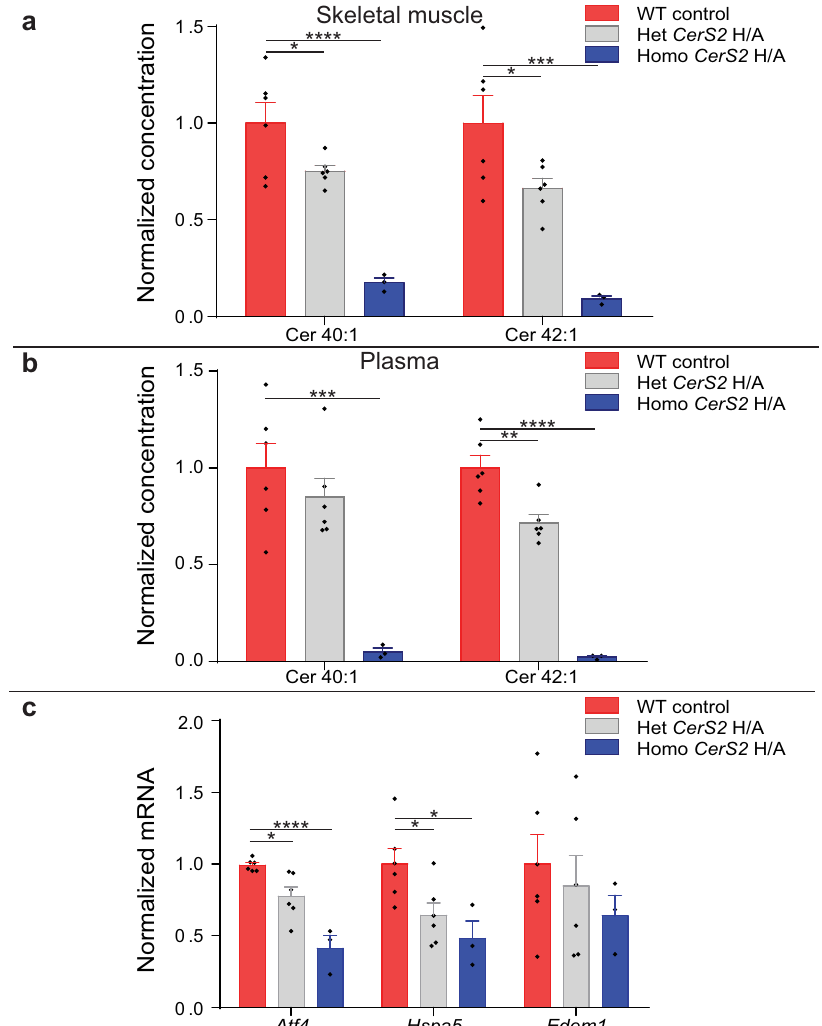
Fig. 6 Transgenic CerS2 inactivation decreases plasma and muscle long-chain ceramides and muscle UPR gene expression. a Ceramides (Cer) 40:1 and Cer 42:1 in the soleus muscle of transgenic mice heterozygous (Het CerS2 H/A; grey) and homozygous (Homo CerS2 H/A; blue) for catalytically inactivated ceramide synthase 2 compared to wildtype (WT; red) (WT, Het CerS2 H/A n = 6; Homo CerS2 H/A n = 3; one-way ANOVA; WT vs Het CerS2 H/A, Cer 40:1 P = 0.03, Cer 42:1 P = 0.03; WT vs Homo CerS2 H/A, Cer 40:1 P < 0.0001, Cer 42:1 P = 0.0005). b Cer 40:1 and Cer 42:1 in the plasma of Het CerS2 H/A (grey) and Homo CerS2 H/A (blue) mice compared to WT (red) (WT, Het CerS2 H/A n = 6; Homo CerS2 H/A n = 3; one-way ANOVA; WT vs Het CerS2 H/A, Cer 42:1 P = 0.0018; WT vs Homo CerS2 H/A, Cer 40:1 P = 0.0006, Cer 42:1 P < 0.0001). c Activating transcription factor 4 ( Atf4 ), Heat Shock Protein Family A (Hsp70) Member 5 ( Hspa5 ) and ER Degradation Enhancing Alpha-Mannosidase Like Protein 1 ( Edem1 ) soleus muscle UPR gene expression in Het CerS2 H/A (grey) and Homo CerS2 H/A (blue) mice compared to WT (red) (WT, Het CerS2 H/A n = 6; Homo CerS2 H/A n = 3; one-way ANOVA; WT vs Het CerS2 H/A, Atf4 P = 0.019, Hspa5 P = 0.02; WT vs Homo CerS2 H/A, Atf4 P < 0.0001, Hspa5 P = 0.019) * P ≤ 0.05, ** P < 0.01, *** P < 0.001, **** P < 0.0001. Data are expressed as mean ± SEM with individual data points. Source data are provided as a Source Data fi